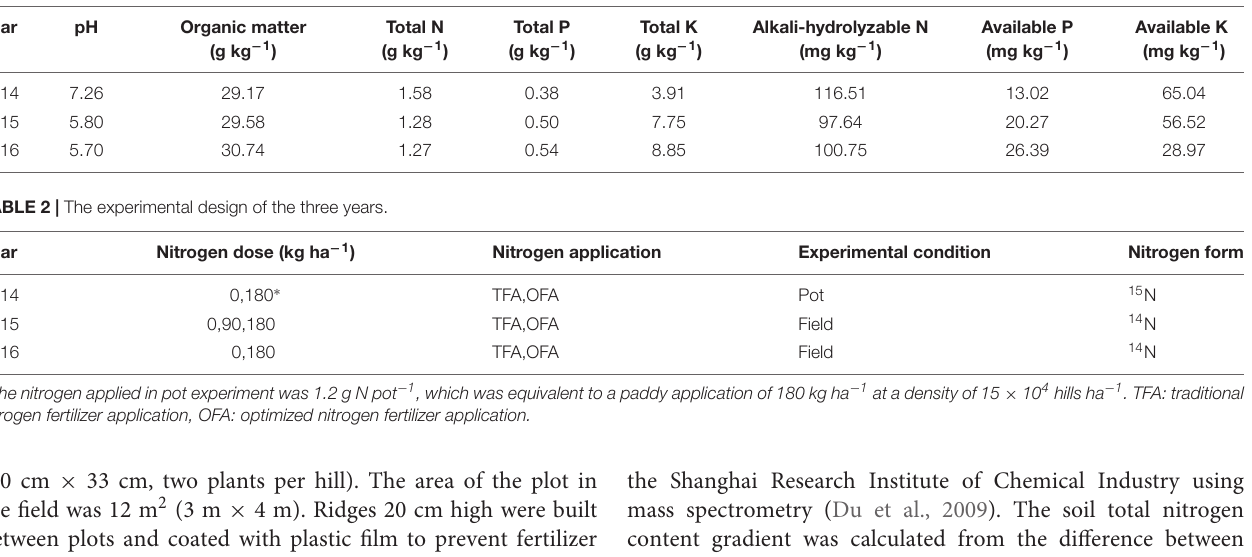
TABLE 1 | Experimental soil characteristics.